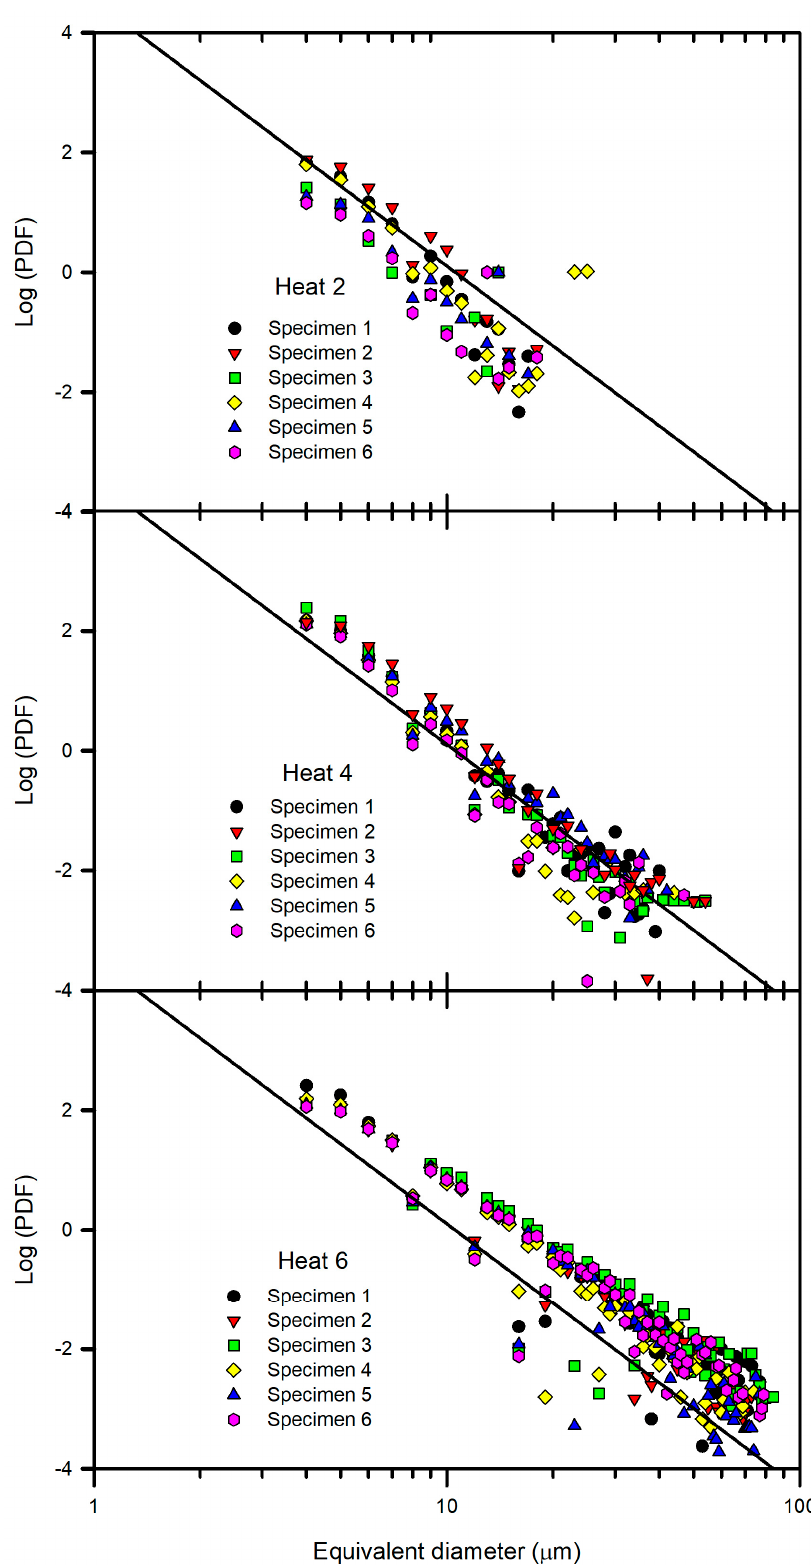
Figure 6. Log-log plot of PDFs versus inclusion equivalent diameter for specimens of Heats 2, 4 and